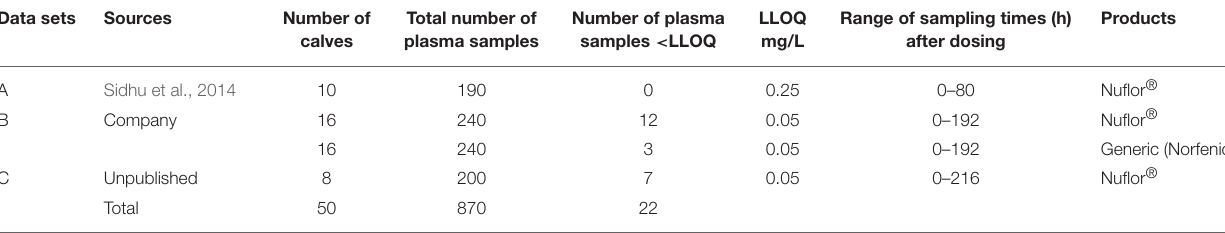
TABLE 1 | The three data sets considered for florfenicol population pharmacokinetic analysis. Data